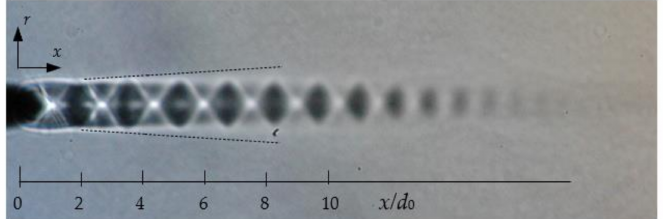
Figure 2. Visualized flow pattern of the under-expanded supersonic jet issued from the Pi-nozzle produced by the Schlieren method, P 0 = 0.380 MPa: The dotted lines indicate the approximate jet boundary with the position of r at u / u c =